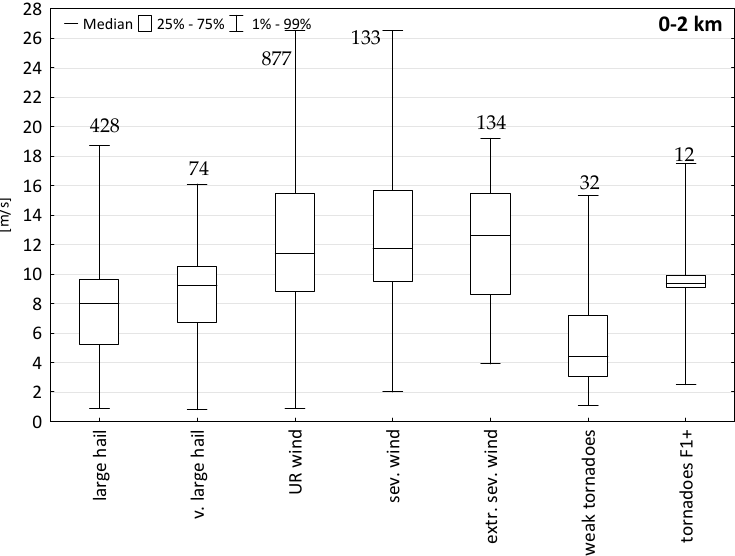
Figure 3. As in Figure 2, except for the 0–2 km bulk wind shear.